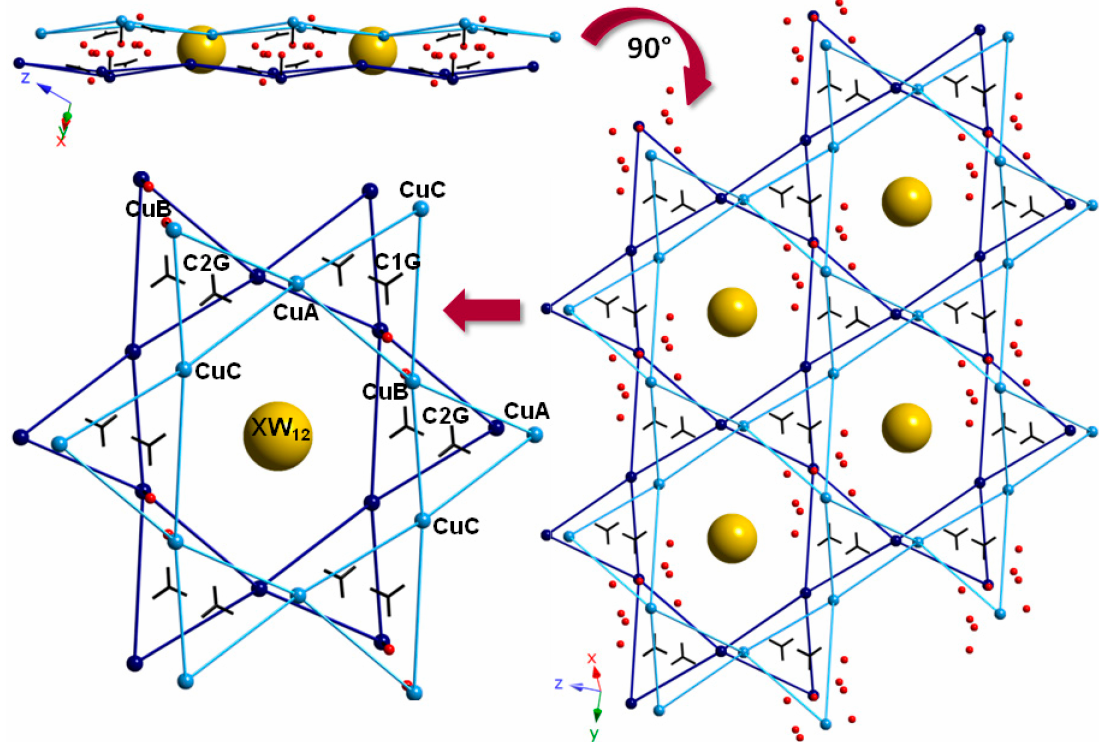
Figure 4. Schematic representation of the guanidinium-templated Kagome-type double lattice of copper(II)-picolinate complexes in 1 and 3